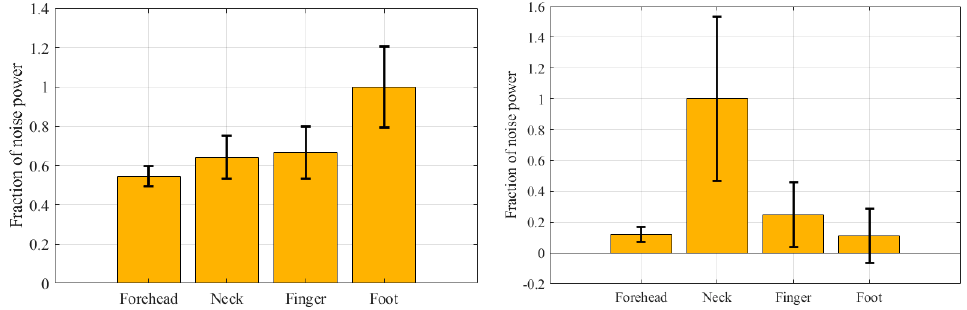
Figure 4. Relative power in the noise band during walking ( left ) and weightlifting ( right ).